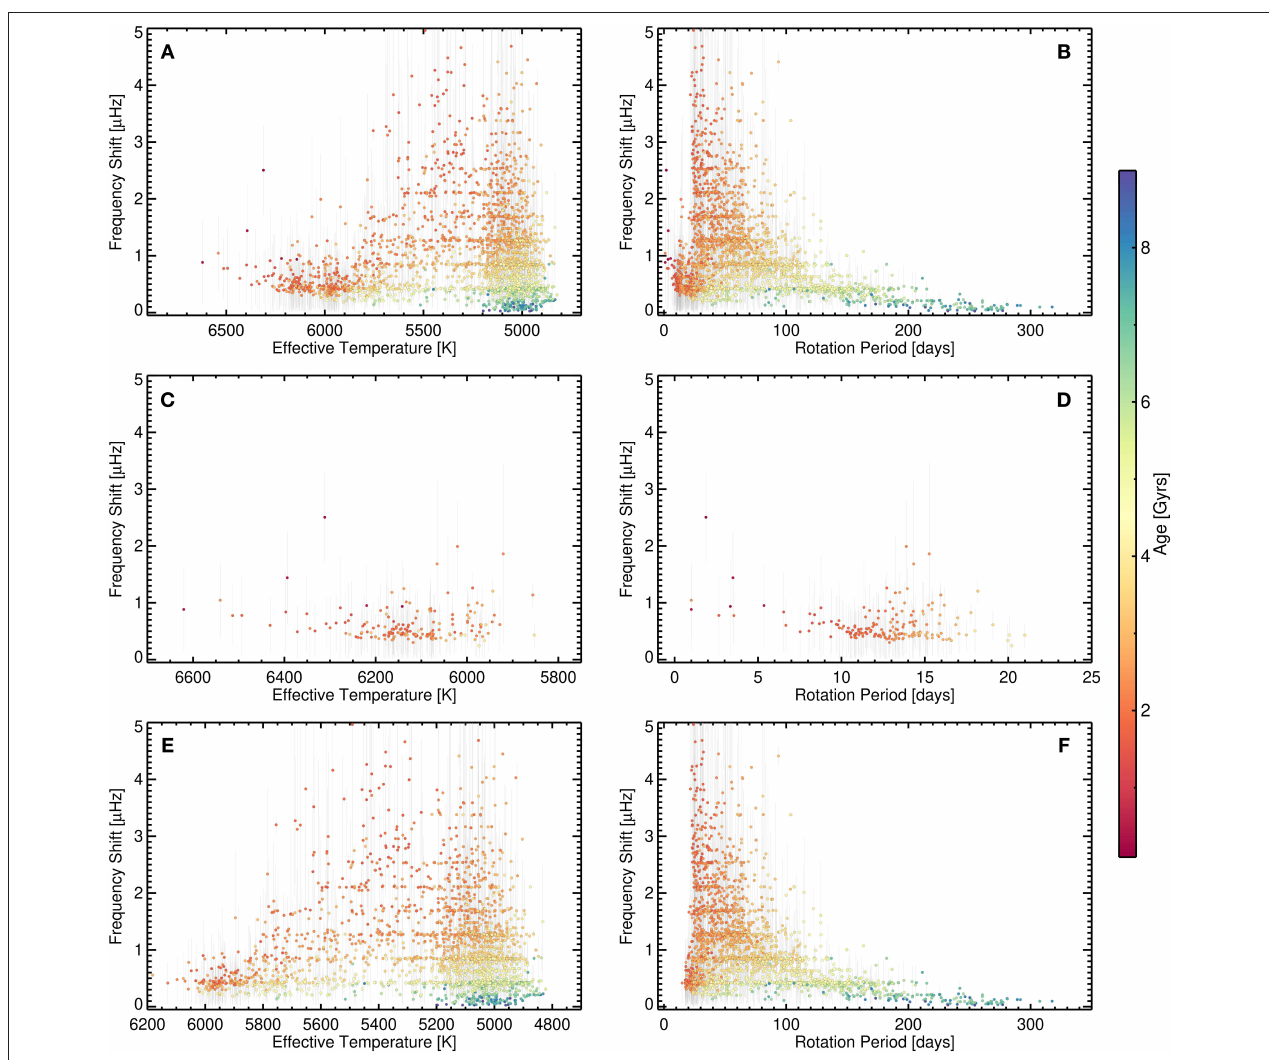
FIGURE 4 | Significant frequency shifts of the synthetic TESS sample for: (A) all stars as a function of effective temperature; (B) all stars as a function of rotation period; (C) stars in region I as a function of effective temperature; (D) stars in region I as a function of rotation period; (E) stars in region II as a function of effective temperature; (F) stars in region II as a function of rotation period. The frequency shifts are measured with the cross-correlation method. Here, a 4 year TESS mission extension is assumed. The color of the dots indicates stellar age as given in the color bar on the right. Note that the range of the abscissa differs from panel to